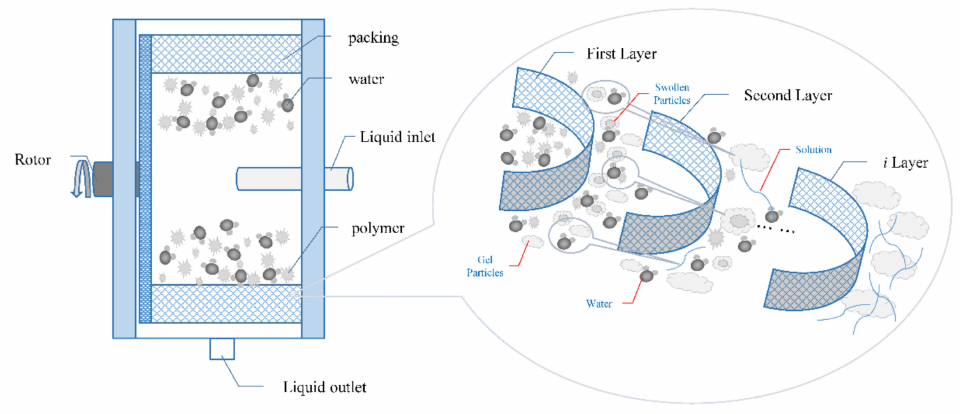
Figure 5. Schematic diagram of accelerated polymer dissolution by super-gravity fast dissolution